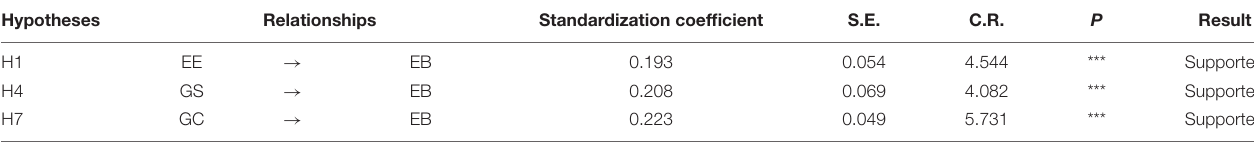
FIGURE 2 | Structural equation modeling (SEM) path analysis. TABLE 3 | Results of path coefficient analysis of structural equation